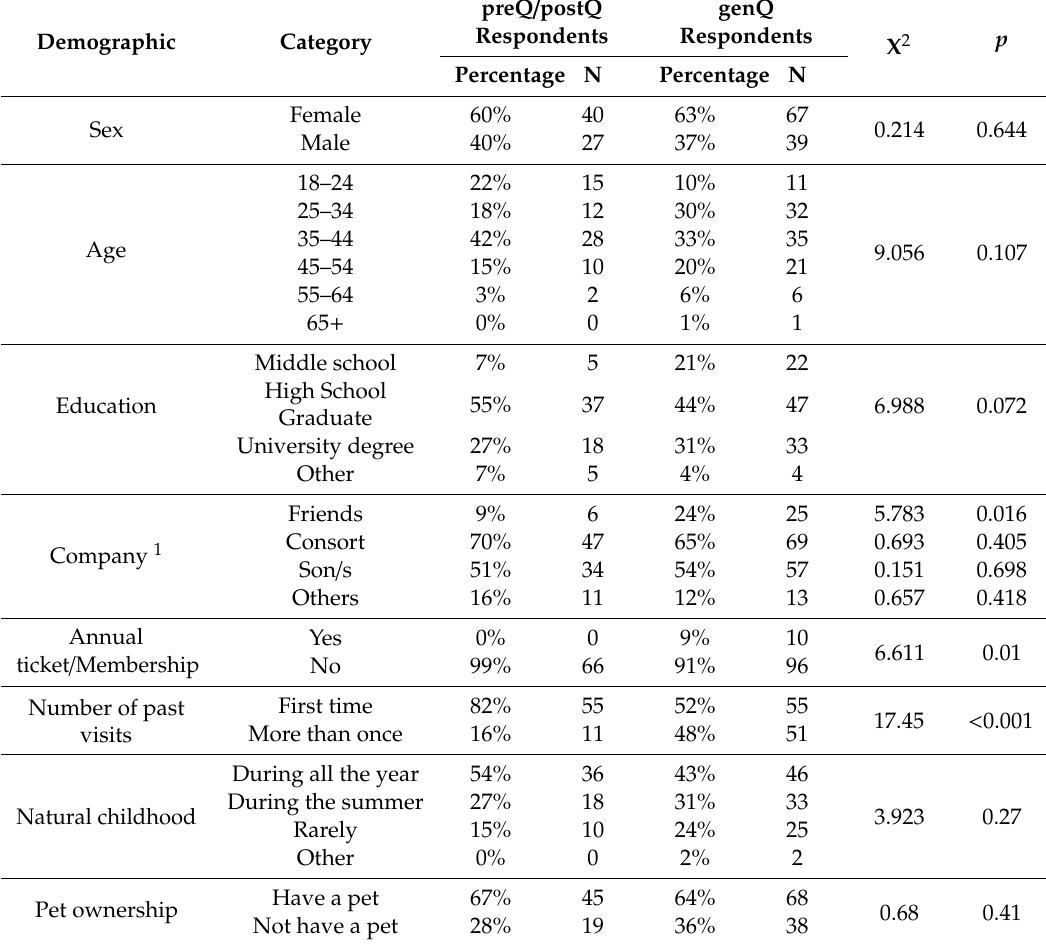
Table A8. Demographic information for respondents of preQ / postQ and genQ.